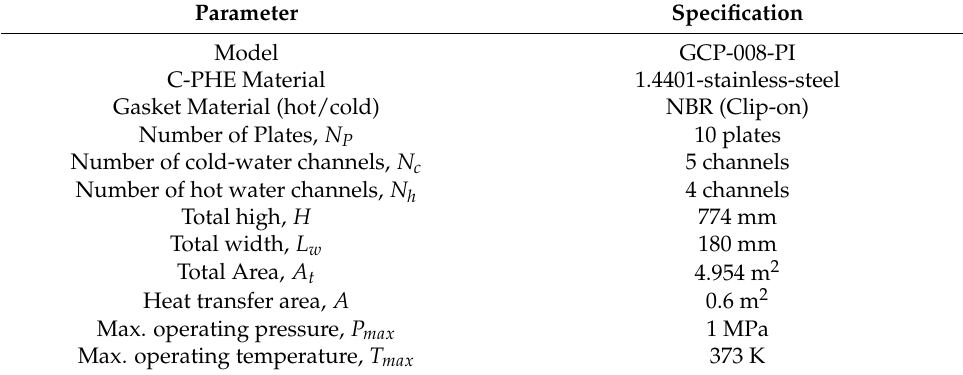
Figure 2. Experimental setup components consist of ( 1 ) CWB, ( 2 ) HWB, ( 3 ) C-PHE, and ( 4 ) corrugated plate channel of PHE. Table 1. C-PHE technical